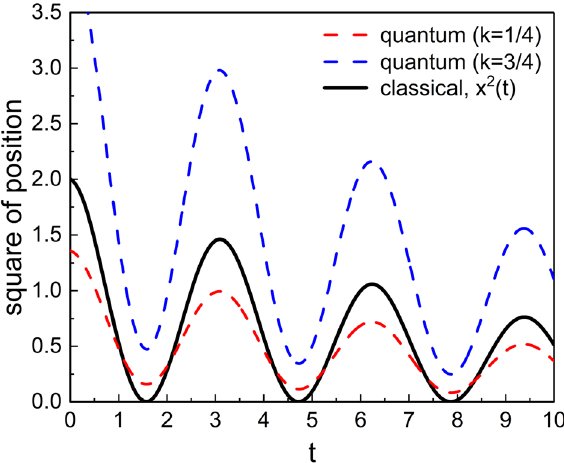
ξ k x 2 k Figure 9. Comparison of the quantum expectation values �˜ ξ with the square of the classical position |˜ ; |ˆ ; � x 2 ( t ) , where the allowed values of k for quantum results are 1/4 and 3/4 as mentioned previously. We used 1 1 , γ 1 , (cid:31) 1 , c 1 1.05 , ω 1 , and s 0,1 0.1 , ϕ 0 0 , m s 0,2 q c 2 = = = = = = = = = =